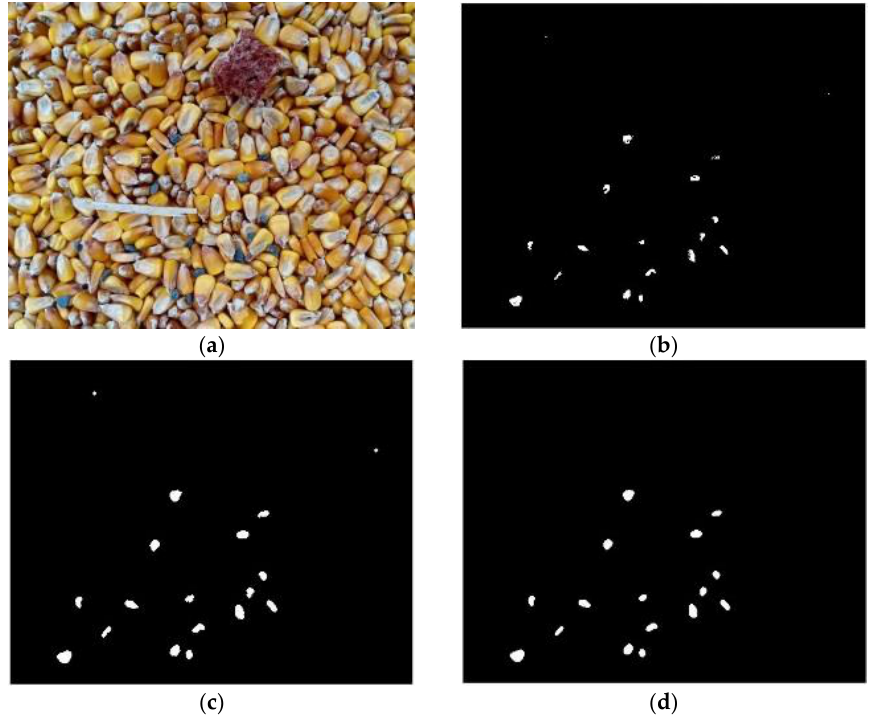
Figure 9. Identification of crushed stones. ( a ) Original image 4 of corn, ( b ) Coarse extraction of crushed stones impurities, ( c ) Expanding, ( d ) Crushed stones impurities. crushed stones impurities, ( c ) Expanding, ( d ) Crushed stones